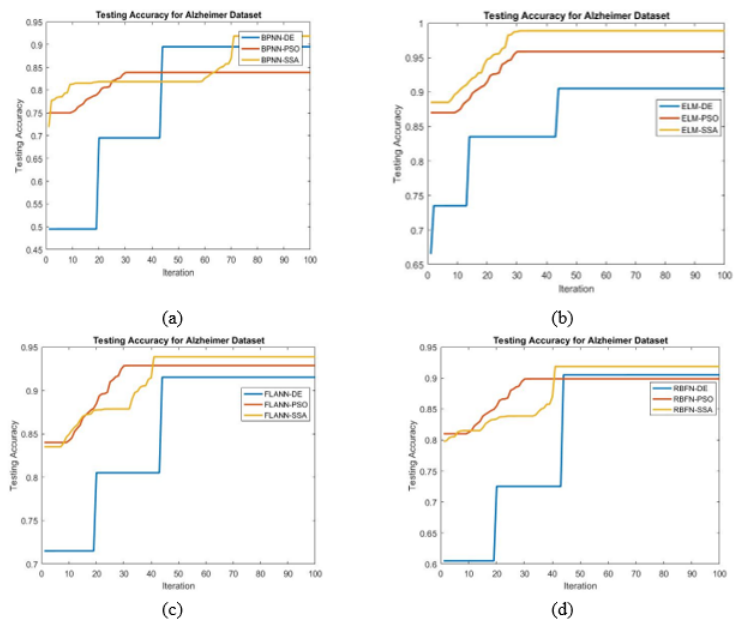
Figure 9. Comparison of Accuracy of classification of Alzheimer’s dataset using ( a ) BPNN, ( b ) ELM, ( c ) FLANN, or ( d )